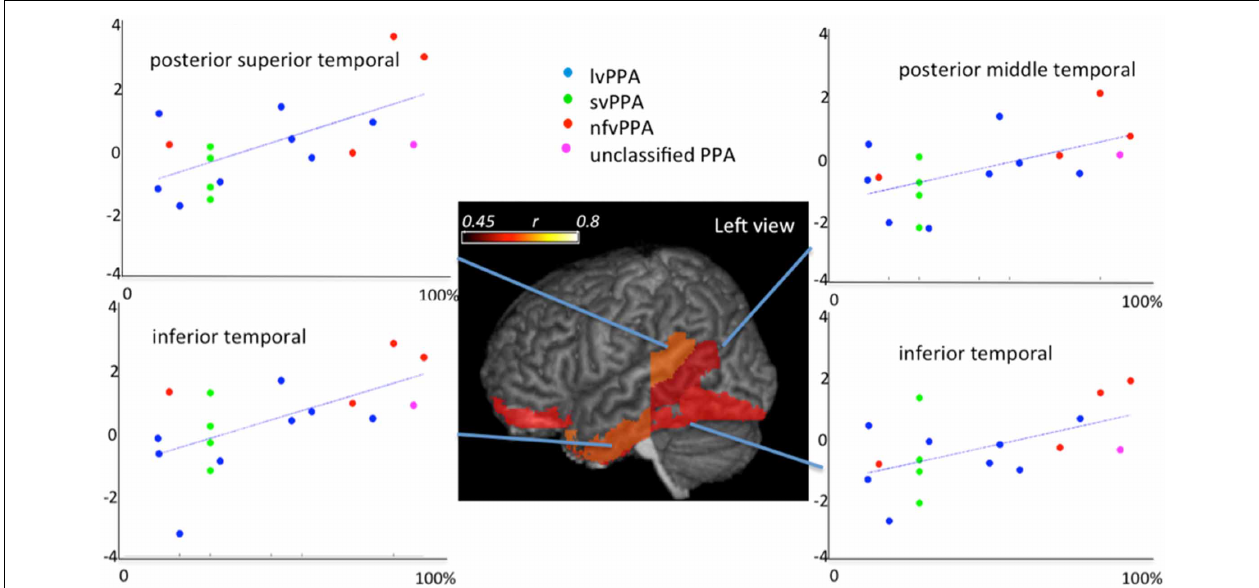
FIGURE 13 | Correlations between regional atlas anatomy ( z -scores of volumes in y axis) and behavior (scores at Boston Naming Test—% of correctness in x axis) in individuals with Primary Progressive